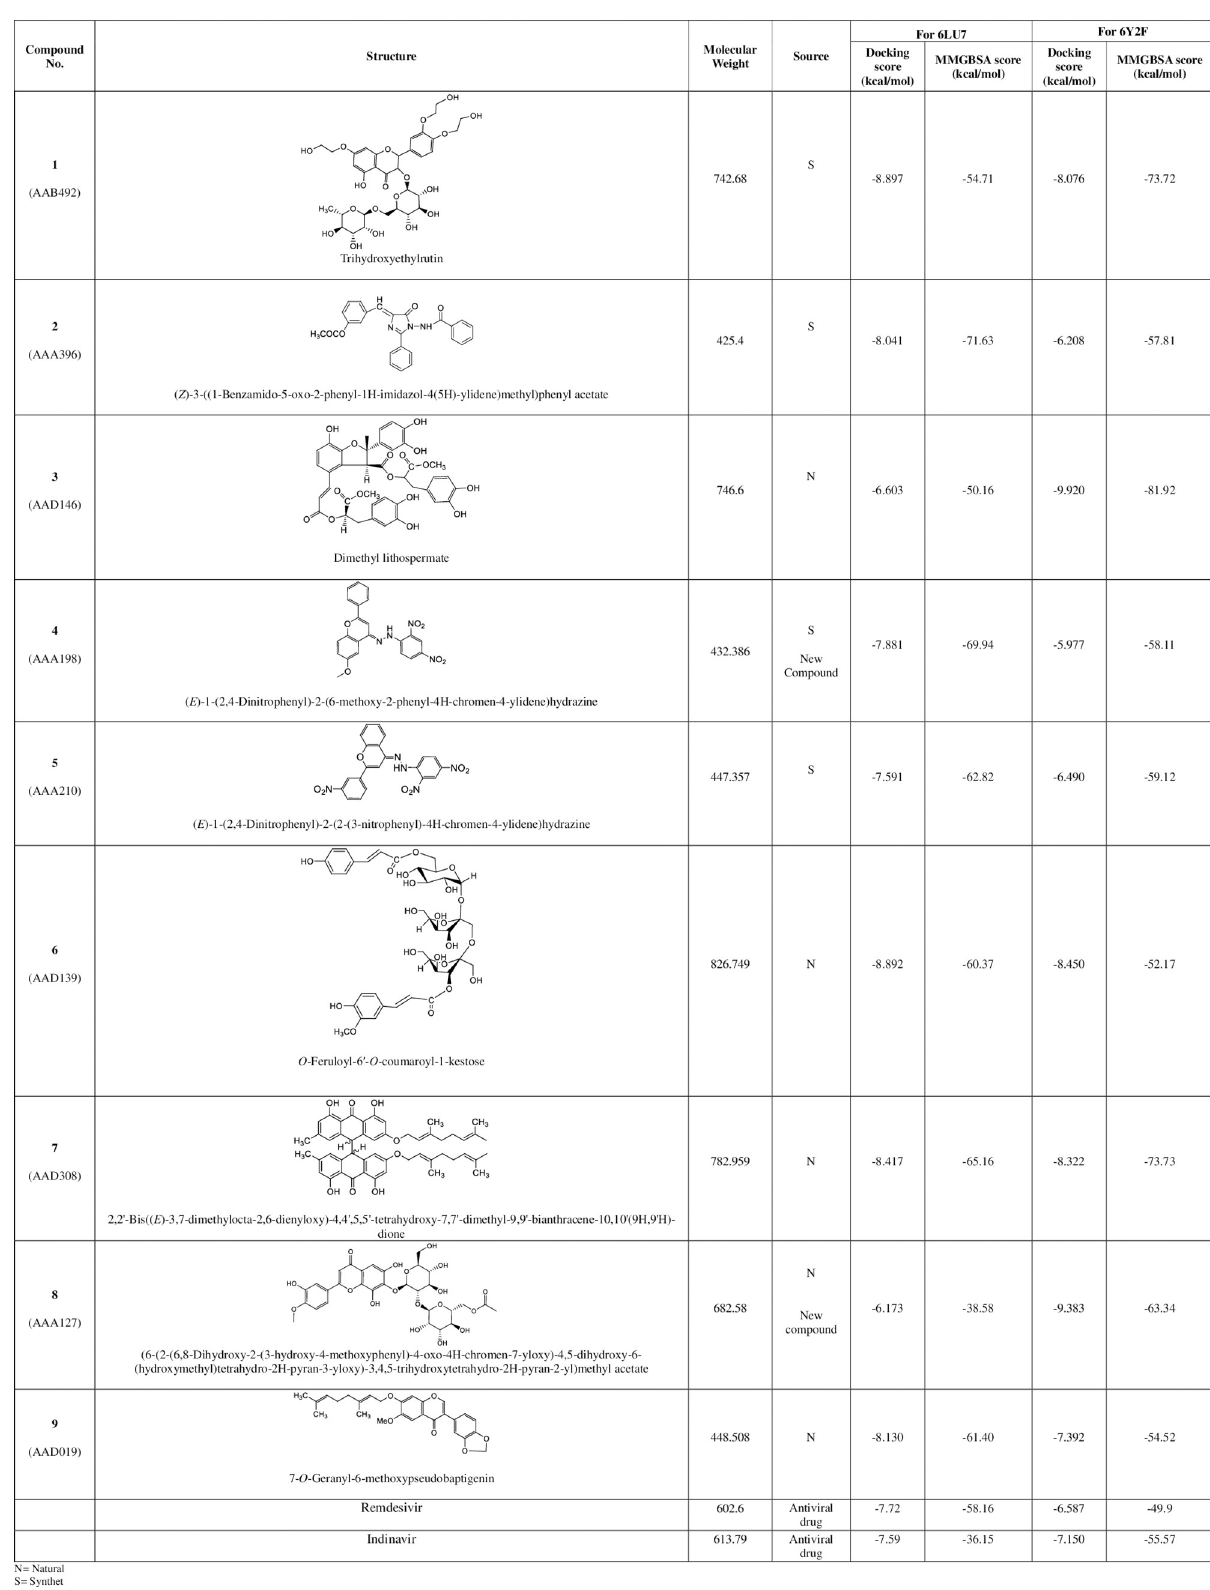
Fig 2. Ligands identified against SARS-CoV-2 3CL protease (6LU7 and 6Y2F) from in-house chemical library via in silico screening. https://doi.org/10.1371/journal.pone.0235030.g002 PLOS ONE | https://doi.org/10.1371/journal.pone.0235030 July 24,